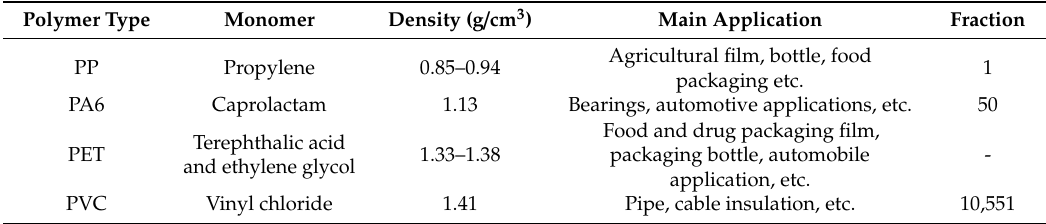
Table 3. Polymer information for MPs detected in this study.